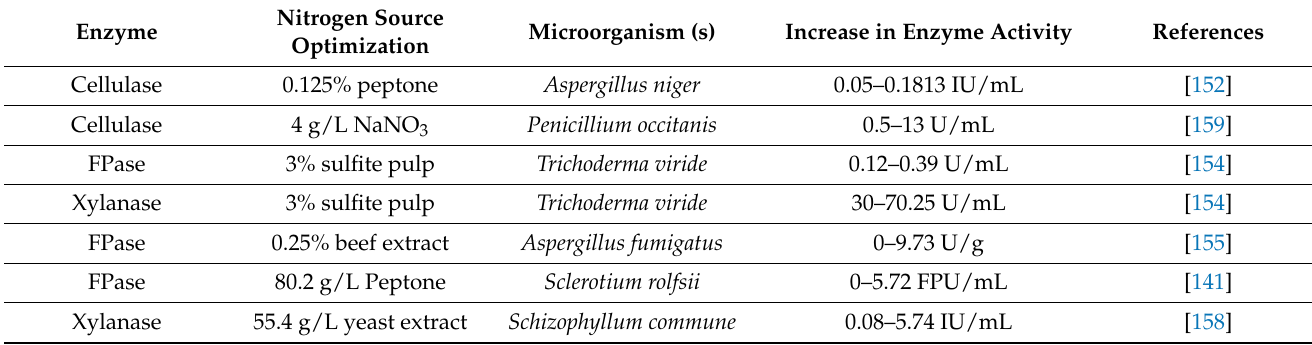
Table 5. Nitrogen source optimization for lignocellulolytic enzyme production